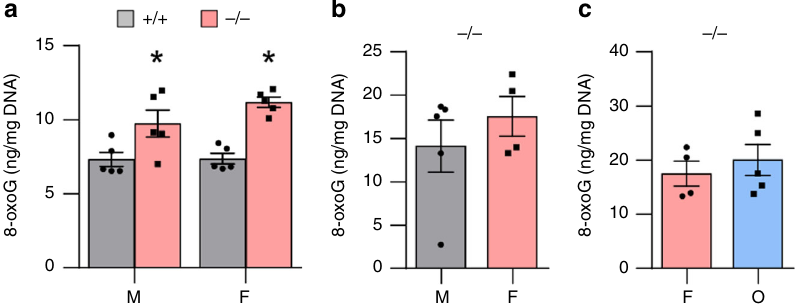
Fig. 9 Assessment of oxidative DNA damage in the inner ears of Gsta4 + / + and Gsta4 − / − mice. a Levels of 8-oxoguanine as an oxidative DNA damage marker were measured in the inner ear tissues from cisplatin-treated male and female Gsta4 + / + and Gsta4 − / − mice. n = 5, * p < 0.05 vs. + / + (unpaired two-tailed Student t test). Error bars represent ± s.e.m. b Levels of 8-oxoguanine were measured in the inner ears from cisplatin-treated male and female Gsta4 − / − mice. The quanti fi cation shows a mean of at least four independent experiments ( n = 4). Error bars represent ± s.e.m. c Levels of 8-oxoguanine were measured in the inner ears from cisplatin-treated female and OVX Gsta4 − / − mice The quanti fi cation shows a mean of at least four independent experiments ( n = 4). Error bars represent ± s.e.m. M: male, F: female, O: ovariectomized female. Source data are provided as a Source Data fi le NATURE COMMUNICATIONS| (2019) 10:4150